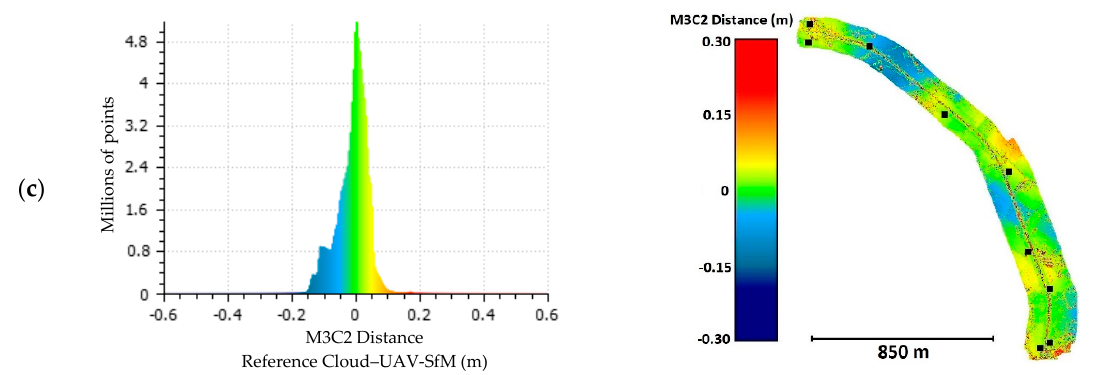
Figure 12. Distribution of errors for the M3C2-calculated distance between the reference cloud and the clouds obtained from the photogrammetric projects that used nine GCPs. The black squares represent the locations of the GCPs. ( a ) Distribution 2, ( b ) Distribution 3, and ( c ) Distribution 4.